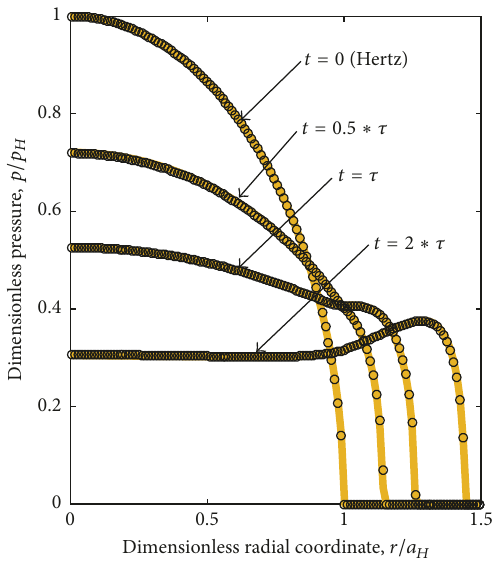
Figure 4: Comparison of pressure history in the step loading spherical indentation of a Maxwell half-space.